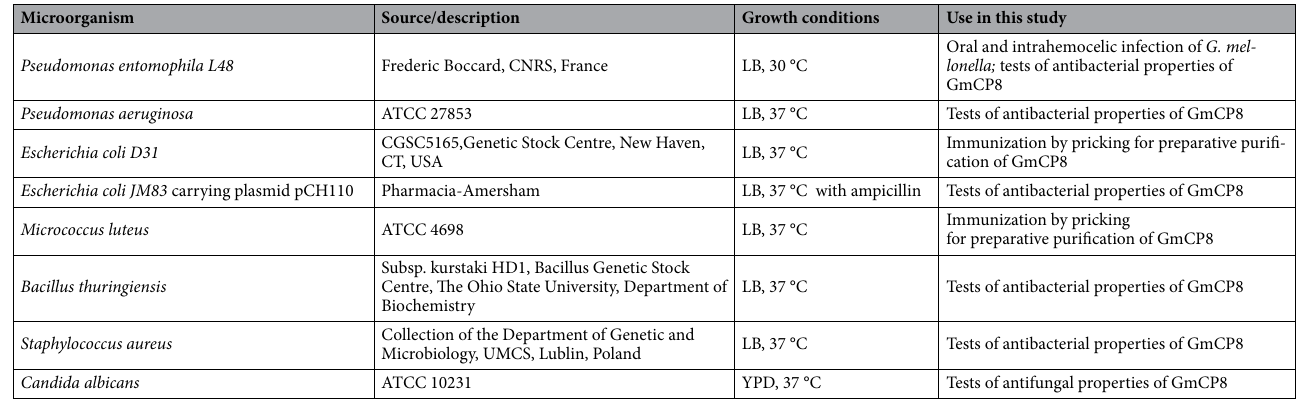
Table 1. Microorganisms used in the